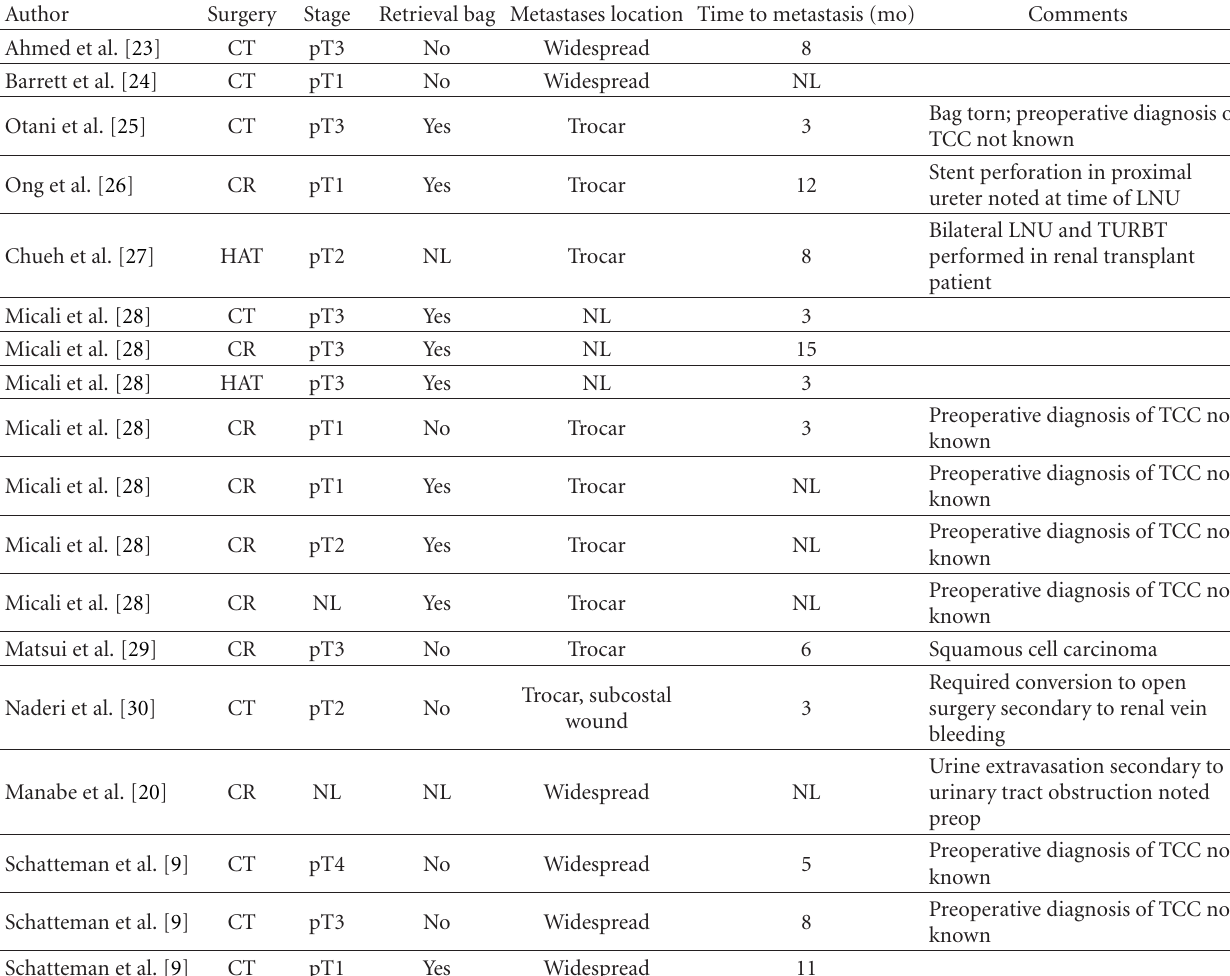
Table 3: Port-site metastasis following LNU. CR, conventional retroperitoneal; CT, conventional transperitoneal; HAT, hand-assisted transperitoneal; LNU, laparoscopic nephroureterectomy; NL, not listed; TCC, transitional cell carcinoma; TURBT, transurethral resection of bladder